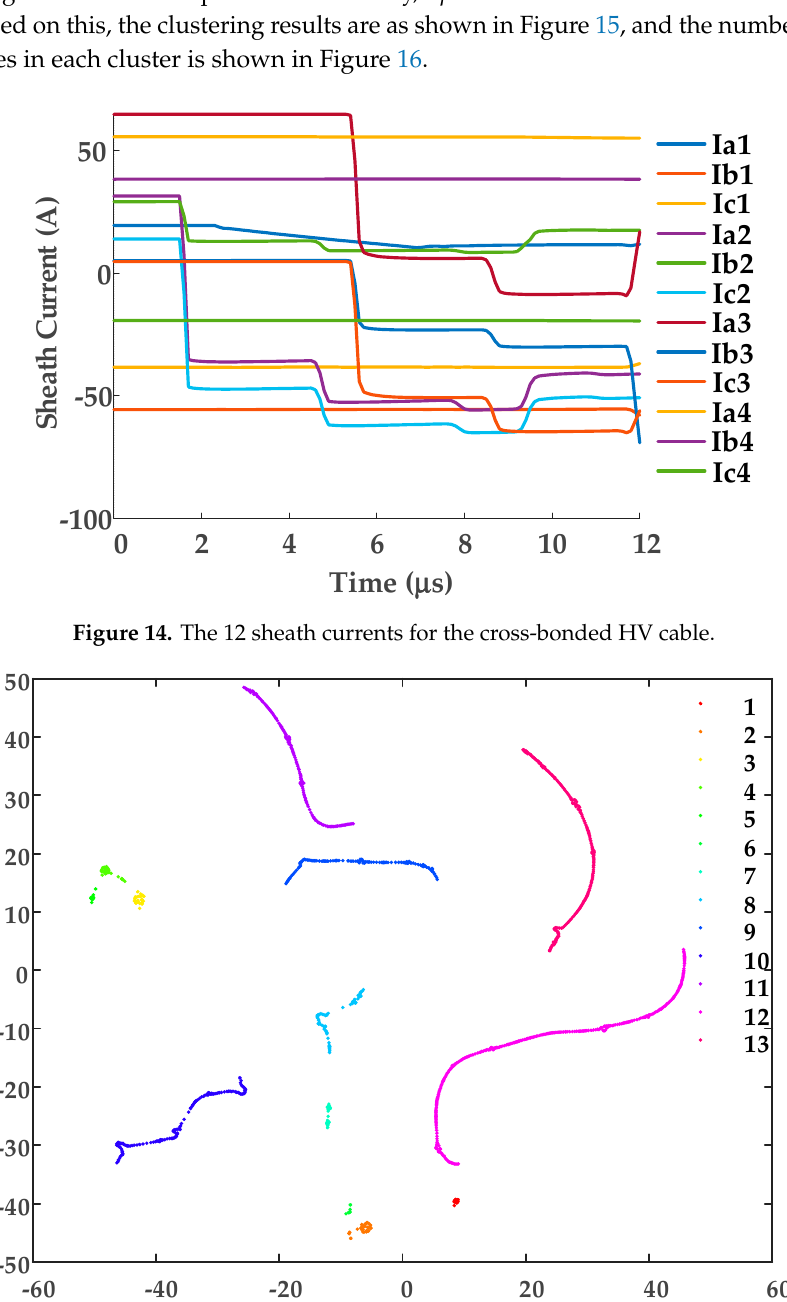
Figure 13. The schematic diagram of the cross-bonded cable circuit. ( I 1 a , I 1 b , I 1 c are, respectively, the